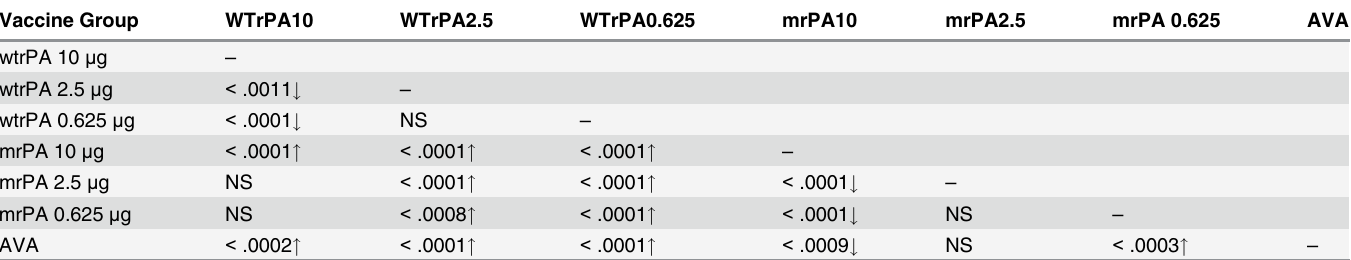
doses of wtrPA when considering the blood draws Days -1 through 65. The highest dose of mrPA was similar to the 2.5 μ g dose of mrPA, but induced a significantly higher amount of functional antibody than either the lowest dose of mrPA or both the 2.5 μ g and 0.625 μ g doses values were measured in rabbits from the highest mrPA dose of wtrPA. Also, higher ED 50 group (10 μ g, p = 0.0002) as compared to AVA. The mrPA outperformed wtrPA at all compa- rable doses and the two lower doses of mrPA were equivalent and not statistically different from the highest wtrPA doses or AVA. In general, an rPA dose response was observed prior to the Day 28 boost, particularly in the wtrPA dosed rabbits. After the Day 28 boost, the differences between doses of rPA, either wild type or mutant, became less apparent and the levels declined between Day 48 and 65 prior to challenge. Neutralizing antibody levels increased post-aerosol challenge in all vaccine groups as seen in Fig 2. Table 4. p Values Associated with Comparison of Ig anti-PA Values between Vaccine Groups as Analyzed by Repeated Measures ANOVA. Vaccine Group